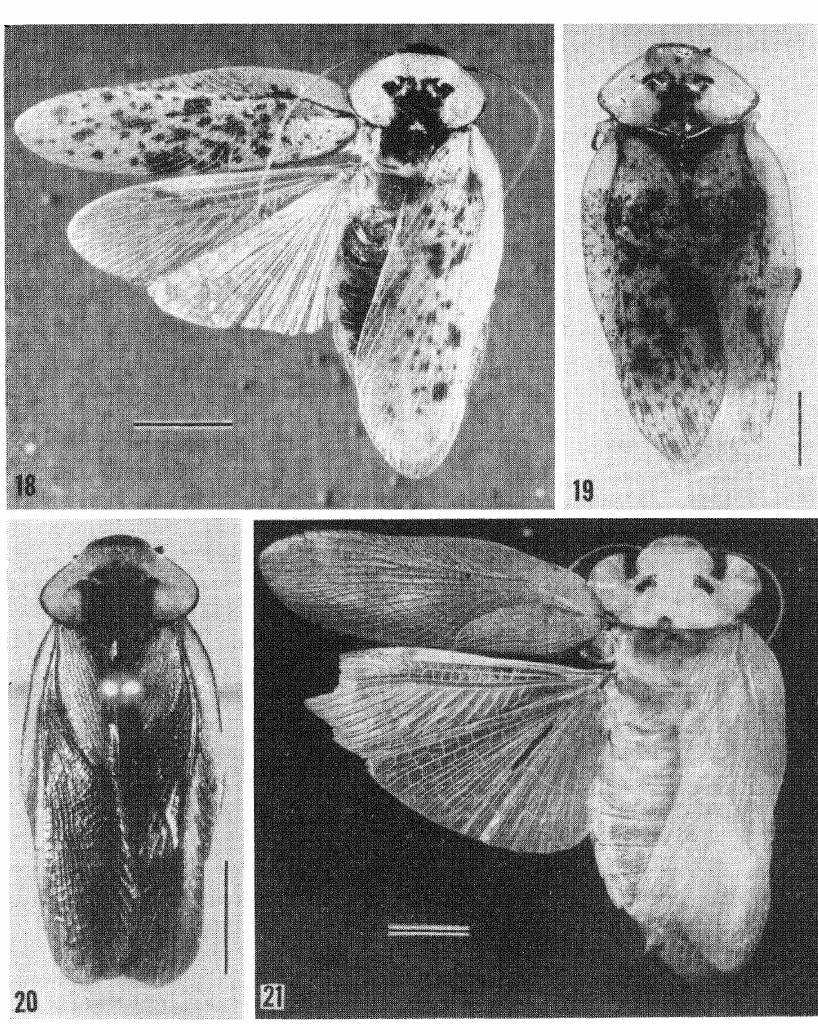
Figs. 18-21. 18. (104 ANSP). Tribonium conspersum (Gurin). Nova Teutonia, Brazil. 19. (103 ANSP). Tribonium colombicum Hebard. Para- type. "New Grenada" ( Colombia). 20. (73 MCZ). Tribonium sp. Brazil. 21. (115 ANSP). Schistopeltis peculiaris Rehn. Holotype 5244. Porto Velho, Rio Madeira, Brazil. (scale